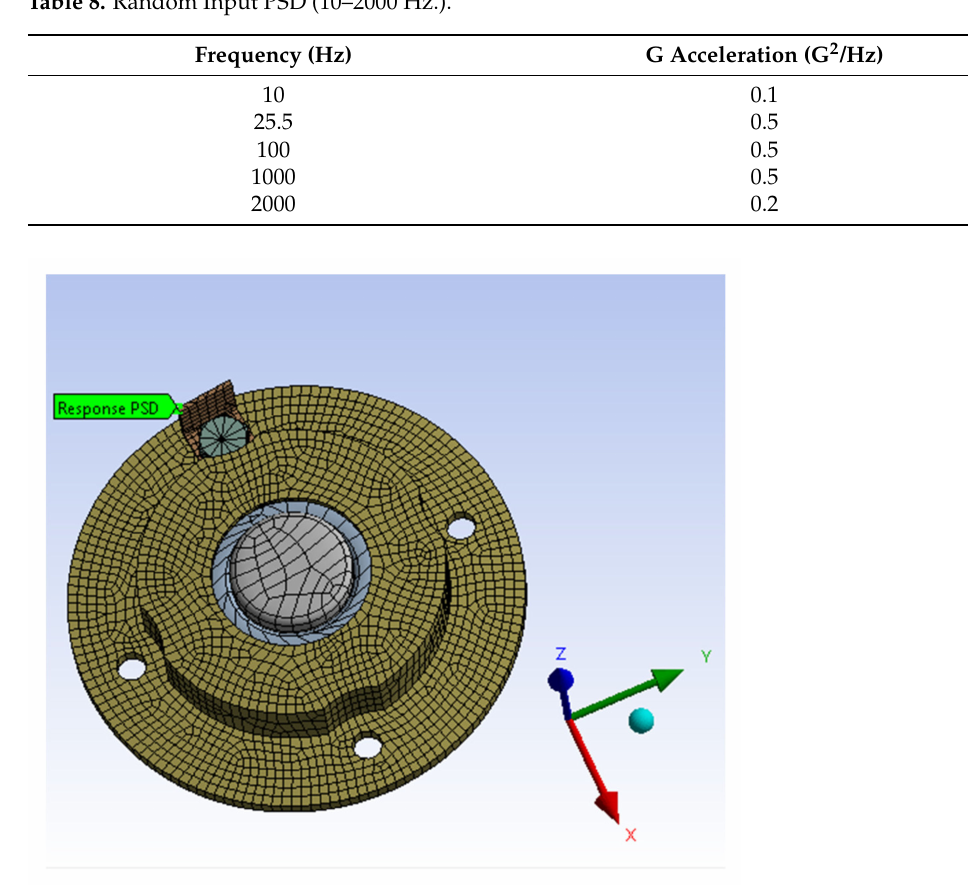
Figure 19. PSD response vertex.